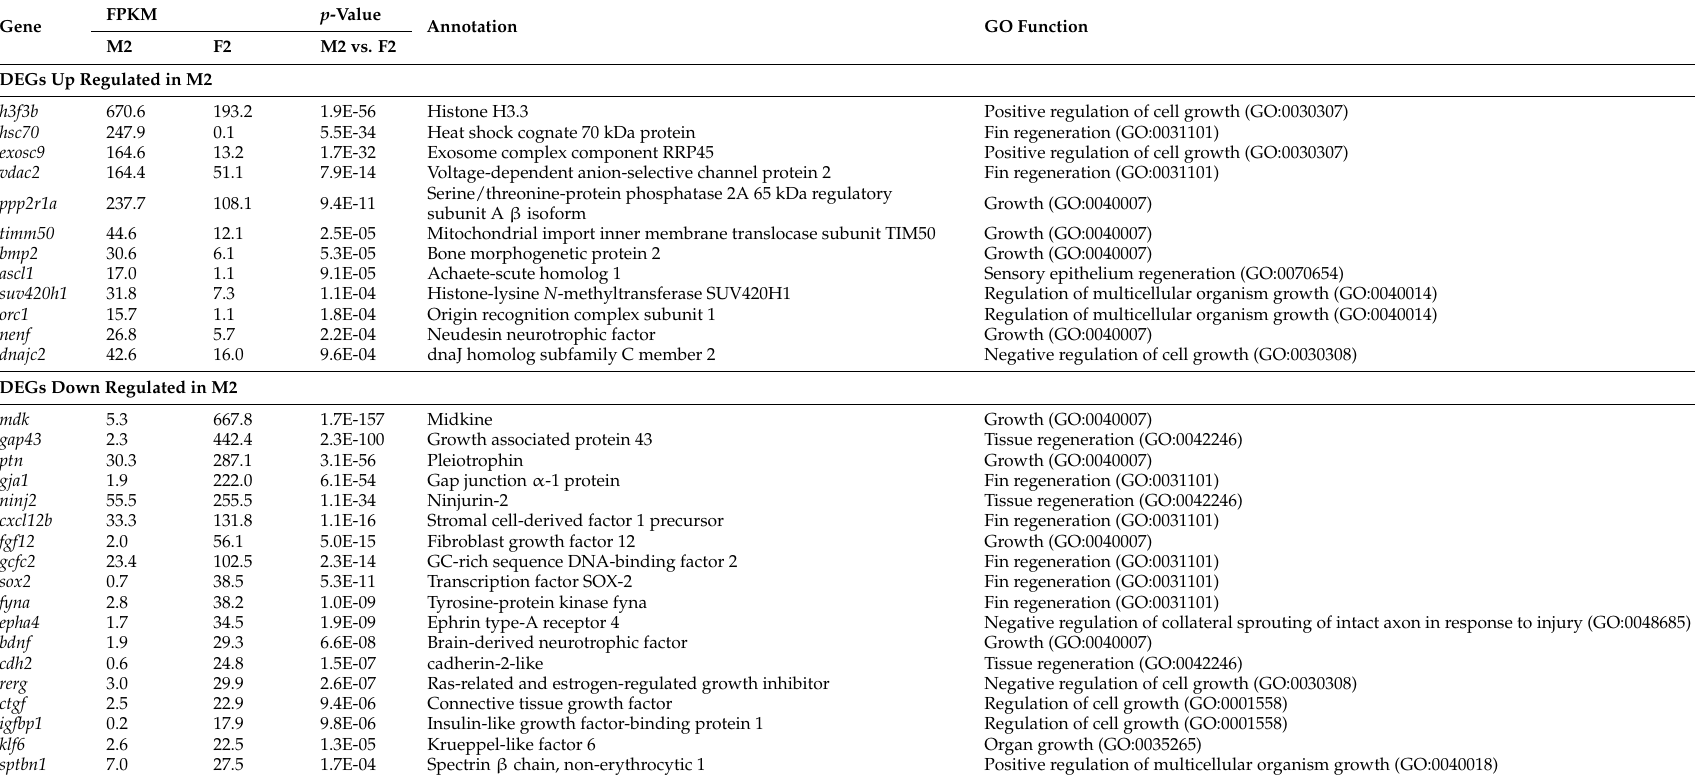
Table 2. Differentially expressed genes (DEGs) in two-year-old tongue sole potentially associated with